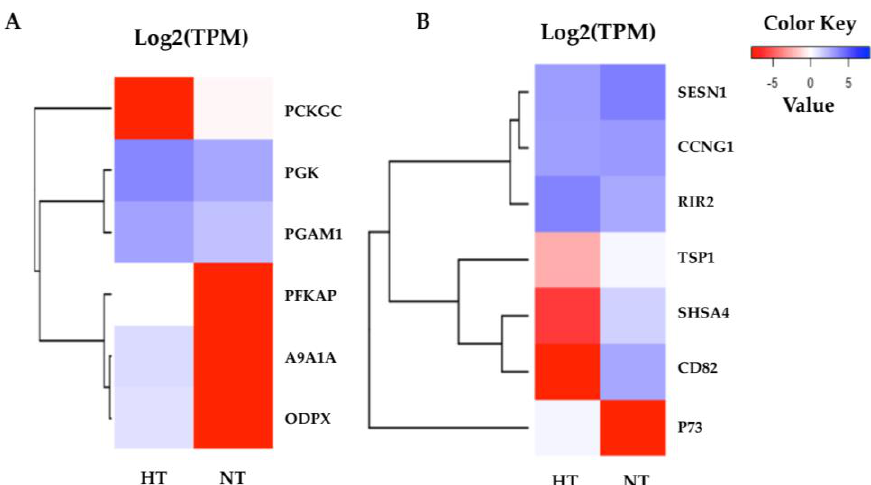
Figure 6. Heatmaps of the specific enriched pathway in adipose fin tissue. ( A ) Six DEGs of glycolysis were highly expressed in the HT group, but not phosphoenolpyruvate carboxykinase cytosolic (PCKGC). ( B ) The seven DEGs of the p53 signaling pathway show the difference between the HT and NT groups. The red indicates less expressed DEGs, and the blue indicates highly expressed DEGs when comparing the HT and NT groups.